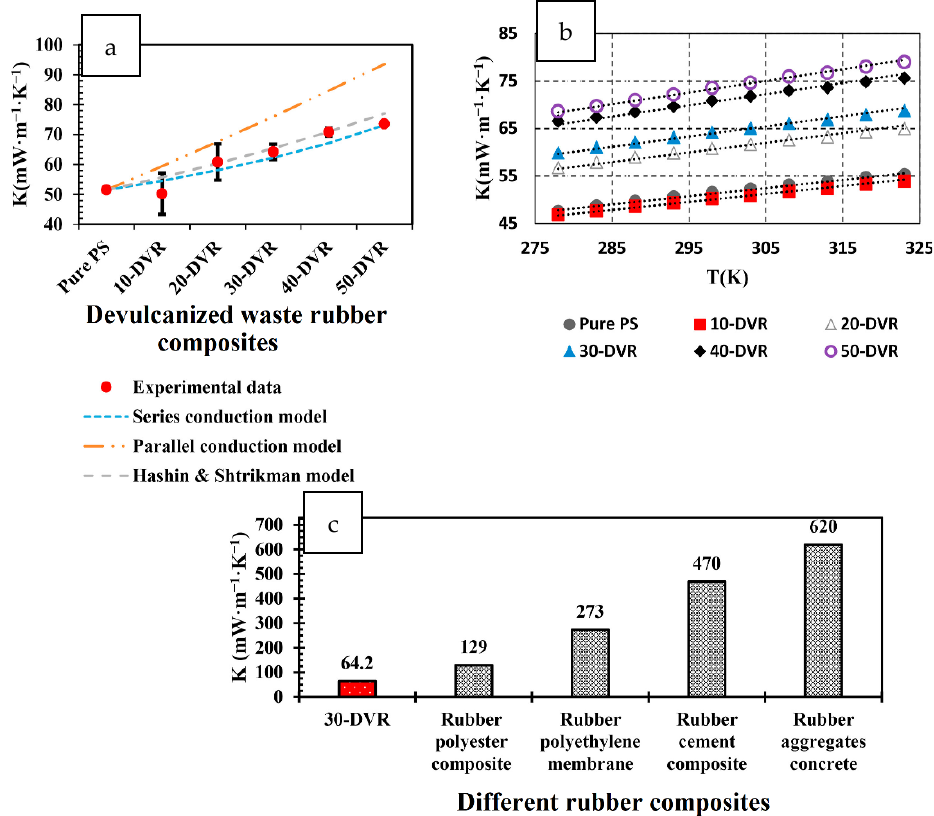
Figure 38. ( a ) Thermal conductivity of DVR – PS composites with varying quantities of DVR at 25 °C; ( b ) thermal conductivity of DVR–PS composite with varying temperatures; and ( c ) comparison of thermal conductivities of DVR – PS with other rubber composites. Reprinted with permission from ref. [103].